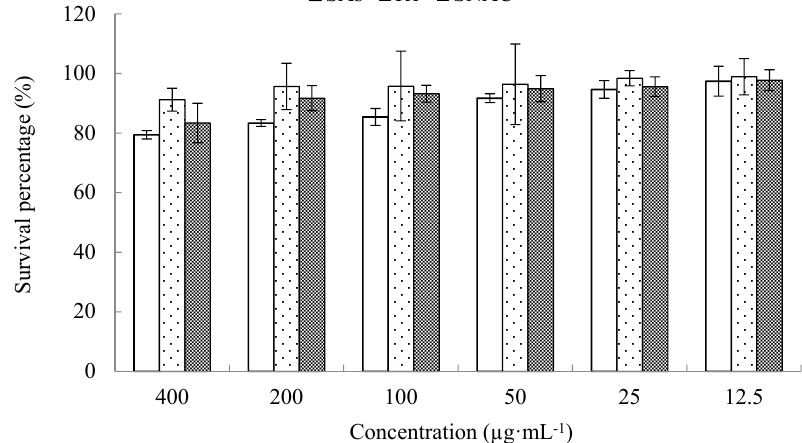
Figure 3. Caco ‐ 2 cells were pre ‐ incubated with notoginsenoside R1, Salvianolic acids and Sodium N ‐ [8 ‐ (2 ‐ hydroxybenzoyl)amino]caprylate (SNAC) for 24 h, and cell viability was assessed by the MTT assay. Values were represented as mean ± SD ( n = 6, each group).